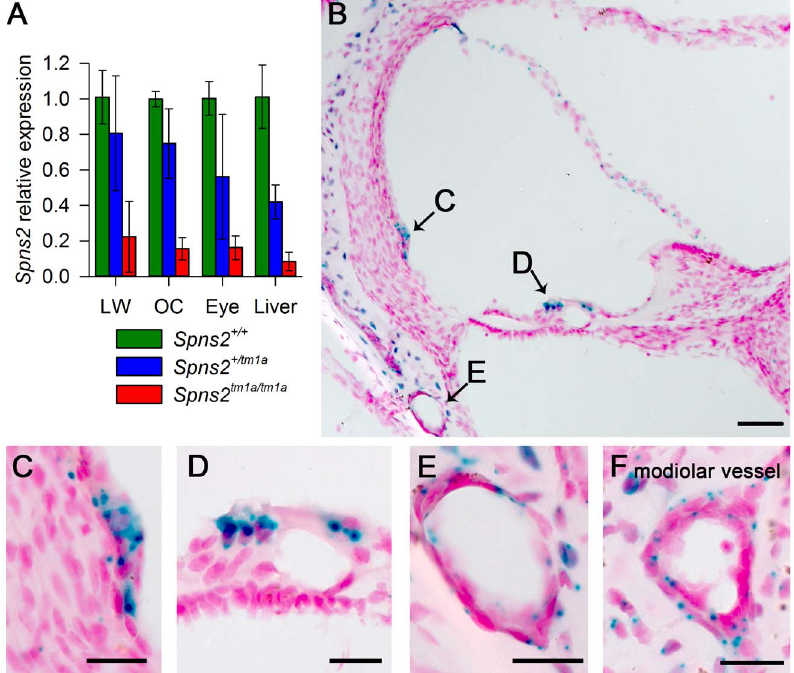
Figure 2. Spns2 is expressed in the cochlea. A , Quantitative real time PCR showed that Spns2 is expressed in the cochlea (OC: organ of Corti, LW: lateral wall) and other organs including the eye, and a small amount of residual transcript remained in the homozygotes (red), ranging from 8% to 22% of wildtype (green) levels. Blue represents heterozygotes. B , X-gal staining showed expression of Spns2 in the cochlea in a homozygote at P10. Labelling (blue) was detected in the spiral prominence area ( B,C ), hair cells ( B,D ), Reissner’s membrane, blood vessels in lateral wall ( B,E ), modiolar vessels ( F ), and bony shell ( B ). Labelling was also seen in the central projection of the auditory nerve (not shown). Nuclei are labelled in red. Scale bar: 50 m m in C, 20 m m in